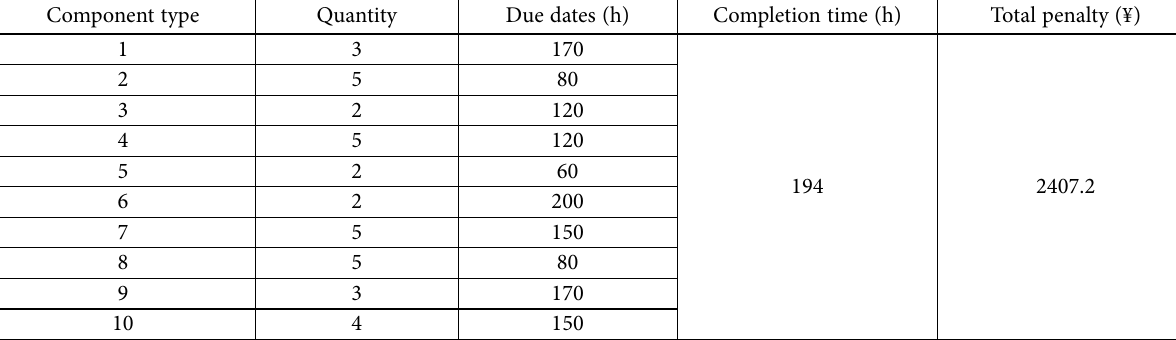
Figure 6. Gantt chart for the optimal scheduling Table 5. Optimization results of the 36-component case in transportation scenario 1 ( g = 1)